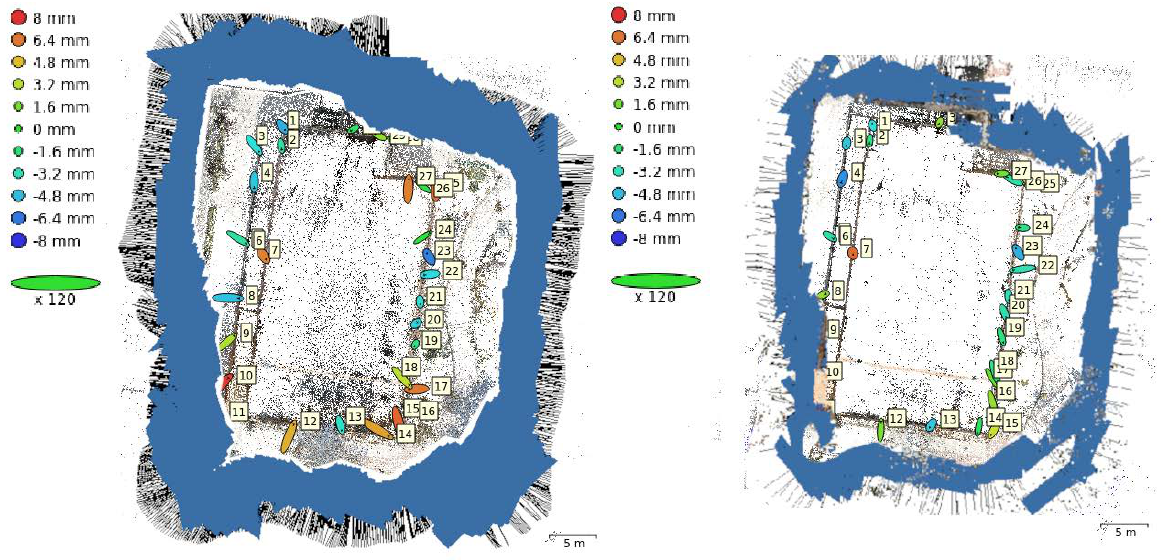
Figure 23. The error ellipsoids on GCPs for the continuous image capturing and the continuous image capturing & clustering and selecting